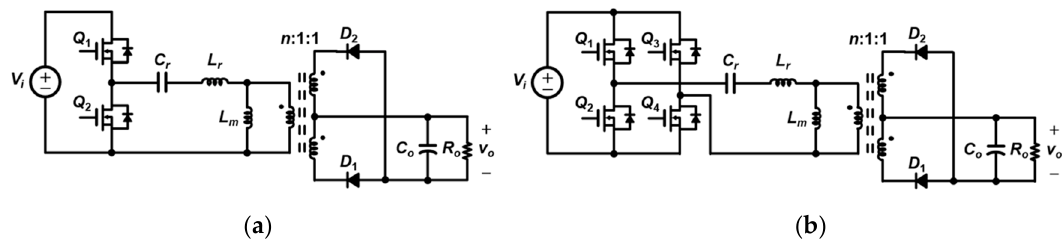
Figure 1. Different topologies of the LLC resonant converter ( a ) half-bridge and ( b ) full-bridge.